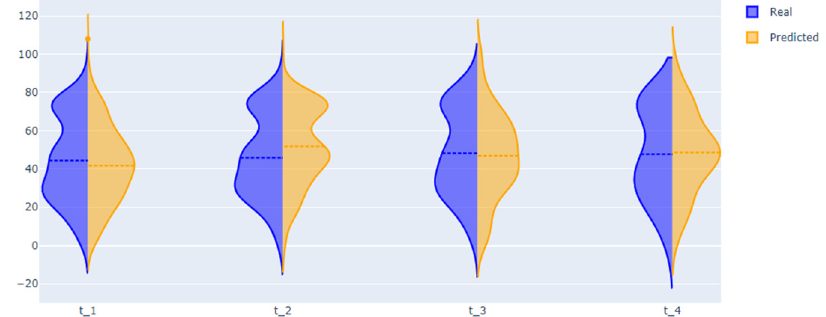
Figure 10. Real and predicted distribution of percentage of lung tissue damage.